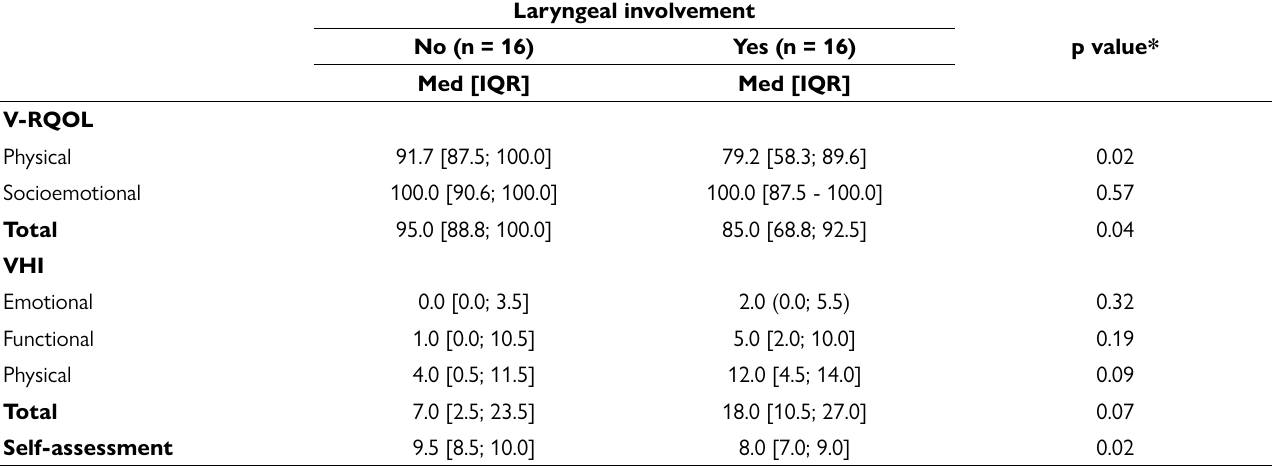
Table 2. Comparison of the vocal analyses performed by three different methods in the treated paracoccidioidomycosis patients with (16 cases) and without (16 cases) laryngeal involvement. Laryngeal